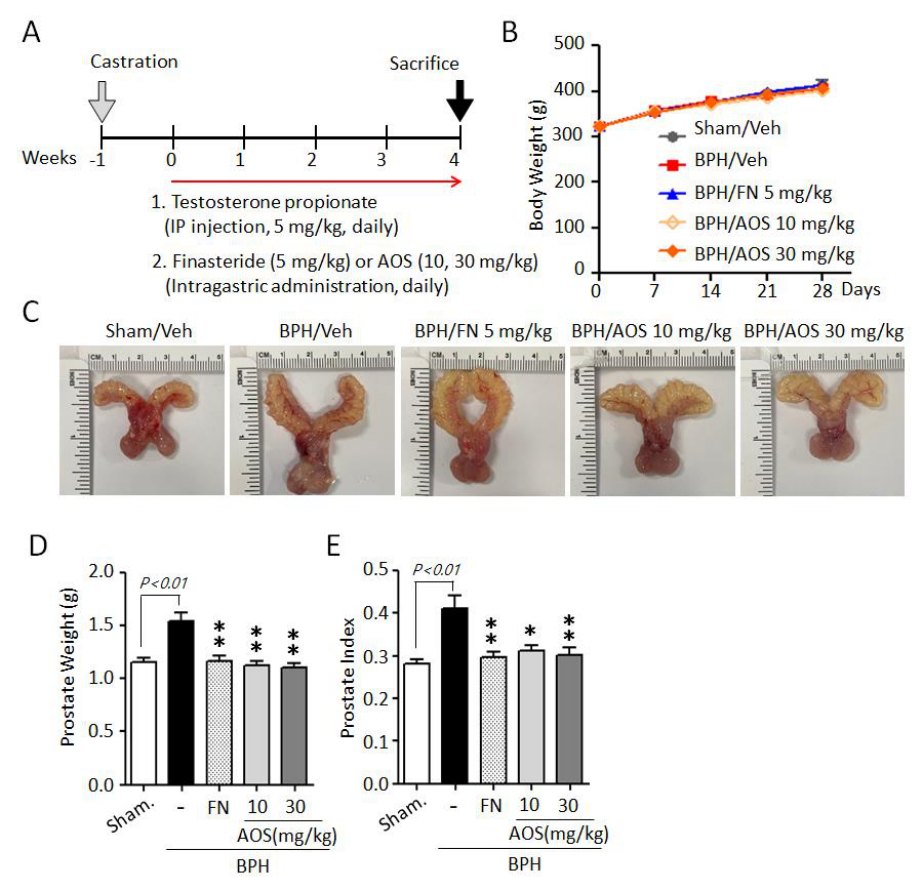
Figure 3. AOS administration suppresses prostate enlargement in rats with testosterone propionate (TP)-induced benign prostatic hyperplasia (BPH). ( A ) Schematic presentation of the experimental procedure. The sham-operated group (Sham/Veh), the negative control, was injected i.p. with corn oil and administered orally with the vehicle. Castrated rats were given daily i.p. injection of TP 5 mg/kg + by gavage: vehicle (BPH/Veh), 5 mg/kg finasteride (BPH/FN), or 10 or 30 mg/kg AOS (BPH/AOS) for 28 days. ( B ) Effect of AOS on body weight. ( C ) Representative images of the prostate for each experimental group. ( D ) Weight of the whole prostate. ( E ) Prostate index (the ratio of prostate weight to body weight). All data are shown as mean ± standard deviation ( n = 5 per group). * p < 0.05, and ** p < 0.01 compared with the BPH/Veh group.